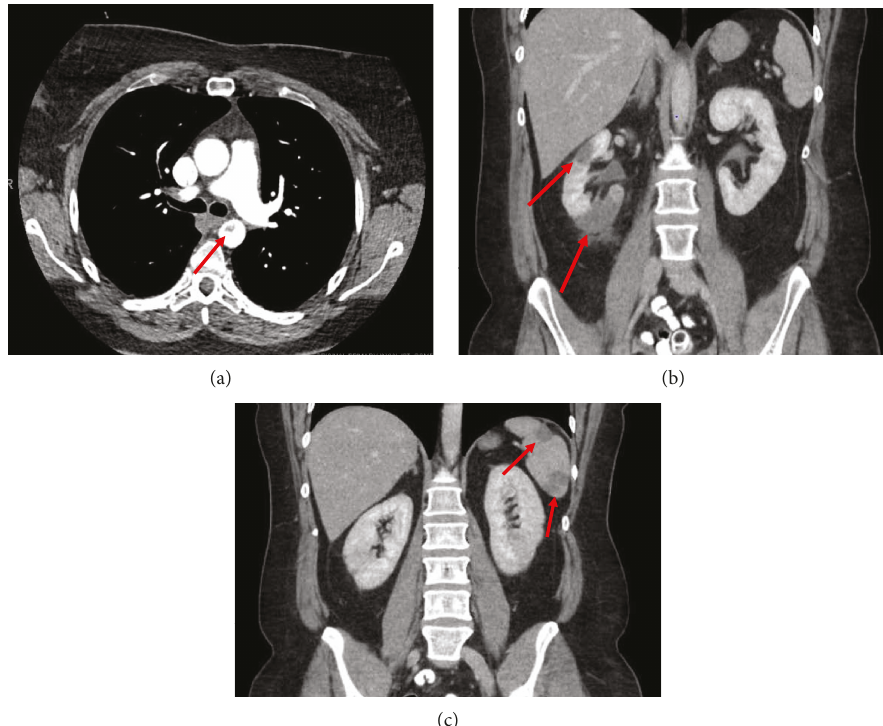
Figure 1: CT of the abdomen and pelvis revealing a mass in the descending thoracic aortia (a) with wedge-shaped infarctions in the right kidney (b) and spleen (c) consistent with an embolic phenomona.